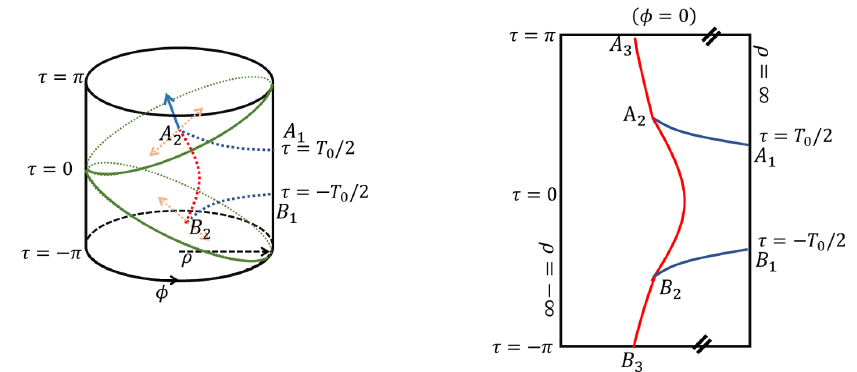
Figure 5 . The global coordinate of AdS 3 spacetime. The green boundary stands for the null boundary of Poincaré patch. The blue and red dashed curves stand for the CWES of Poincaré patch. The right panel is the cut of φ = 0 . The blue and red solid curves stand for the spacelike and timelike geodesics. Note that the global AdS 3 spacetime has topology S 1 × R 2 , of which the time coordinate is periodic τ ∼ τ + 2 π . Thus, the point A 3 and B 3 are same point and curve A 2 A 3 B 3 B 2 A 2 forms a closed